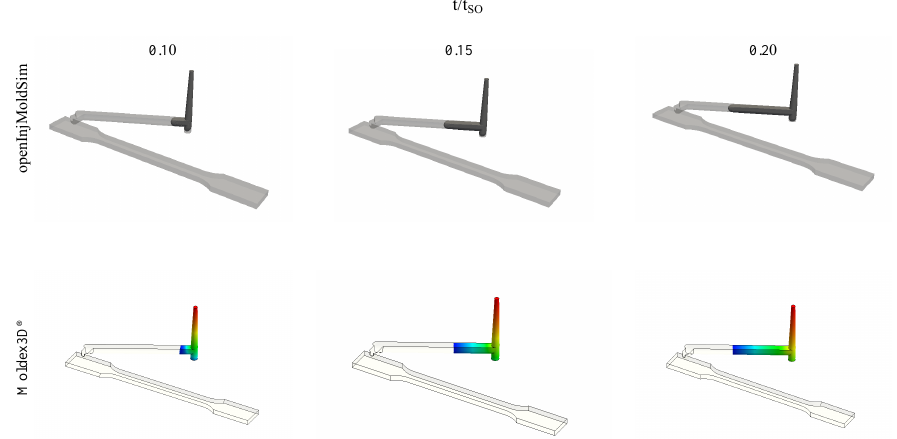
Figure 12. Melt front location for t / t SO = 0.1, 0.15, and 0.2 predicted by both openInjMoldSim and (cid:13) Moldex 3 D R [11].